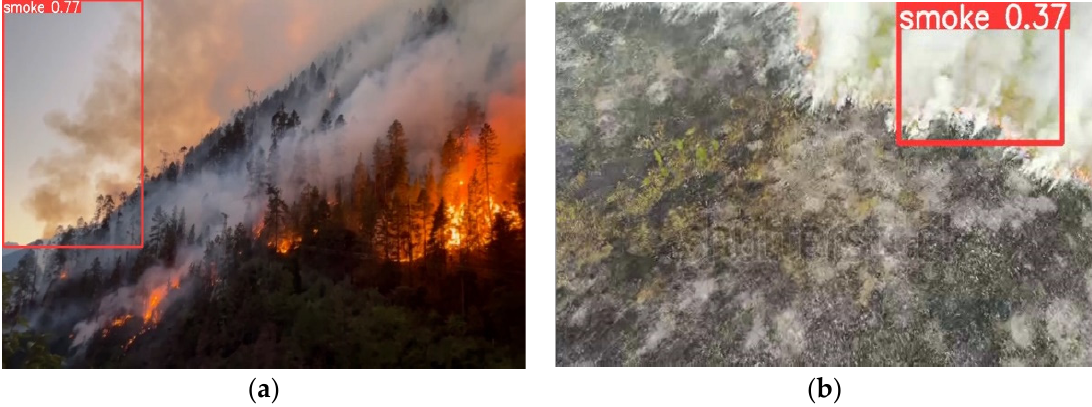
Figure 6. First-stage smoke detection and some experimental results: the model can detect specific colors of smoke (white smoke) due to the limitation of the dataset (( a ) model 1 and ( b ) model 2).